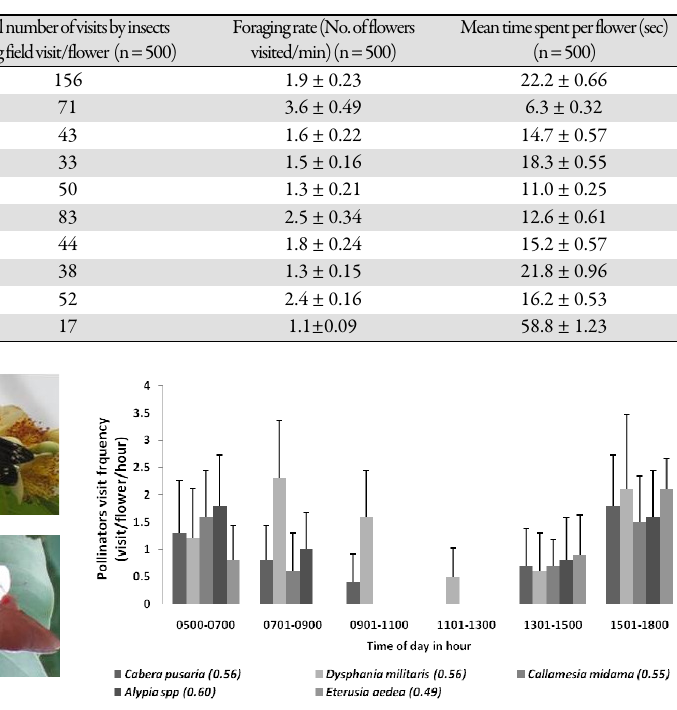
Fig. 2. Frequency of pollinators (moths) visitation in respect to the time of day for S. wallichii in the year 2012 (values in parentheses indicate LSD values for 5%)